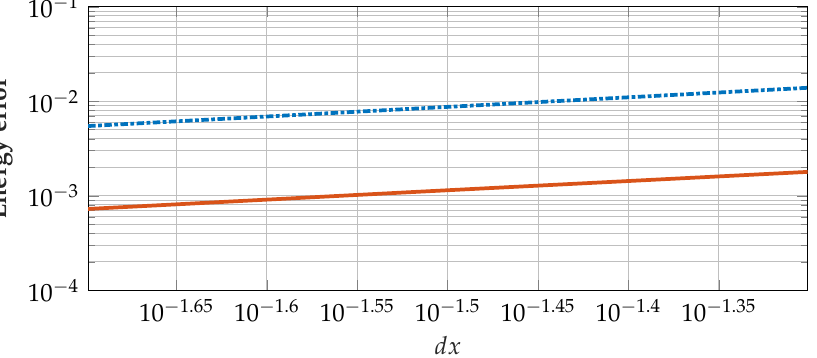
Figure 7. Convergence plots of the numerical solution of the non-linear seismic wave equation using exponential integrator and the standard scheme of